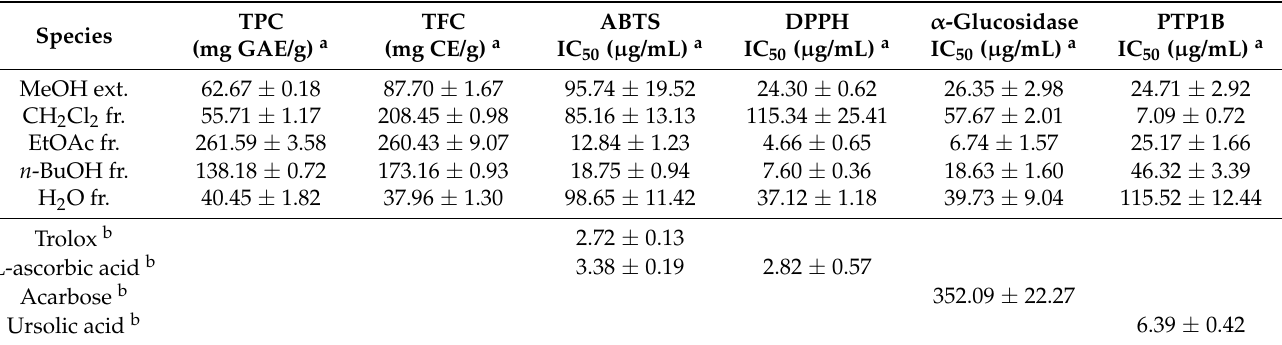
Table 2. TPC/TFC values and ABTS/DPPH radical scavenging activities and α -glucosidase/PTP1B enzyme inhibitory activities of extract and its organic solvent fractions from Morus bombycis